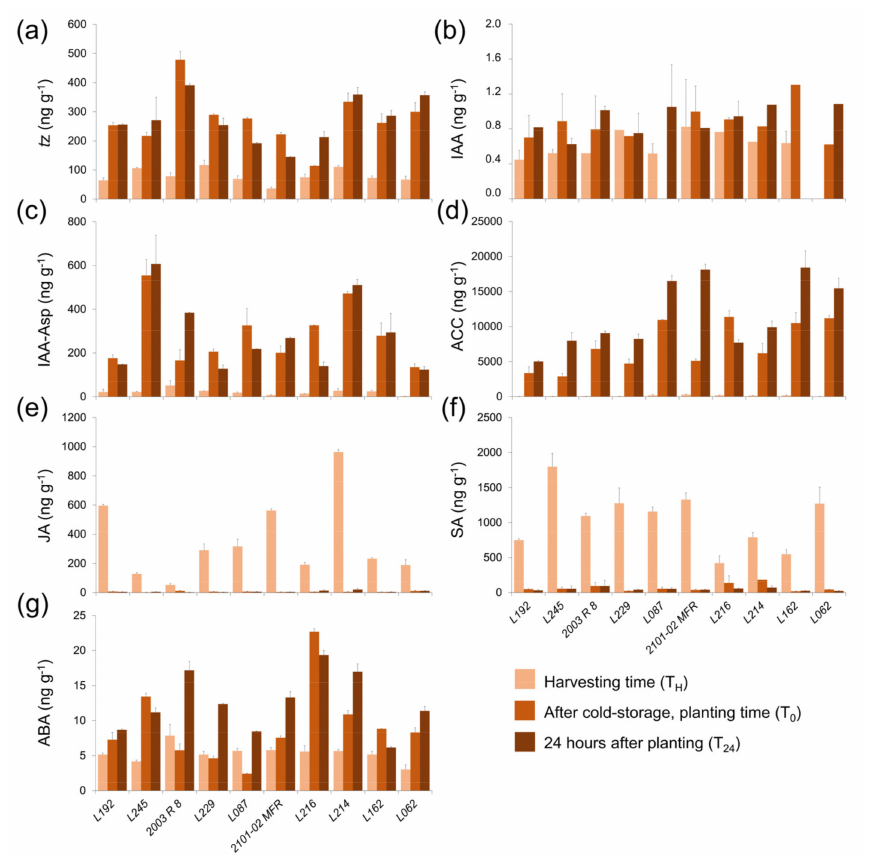
Figure 7. Hormonal profiling in selected lines for the third experiment. Bar charts at harvesting time (T H ), at planting time (T 0 ), and 24 hours after planting (T 24 ) for ( a ) trans -zeatin ( t Z), ( b ) indole-3-acetic acid (IAA), ( c ) indole-3-acetyl-aspartate (IAA-Asp), ( d ) 1-aminocyclopropane-1-carboxylic acid (ACC), ( e ) jasmonic acid (JA), ( f ) salicylic acid (SA), and ( g ) abscisic acid